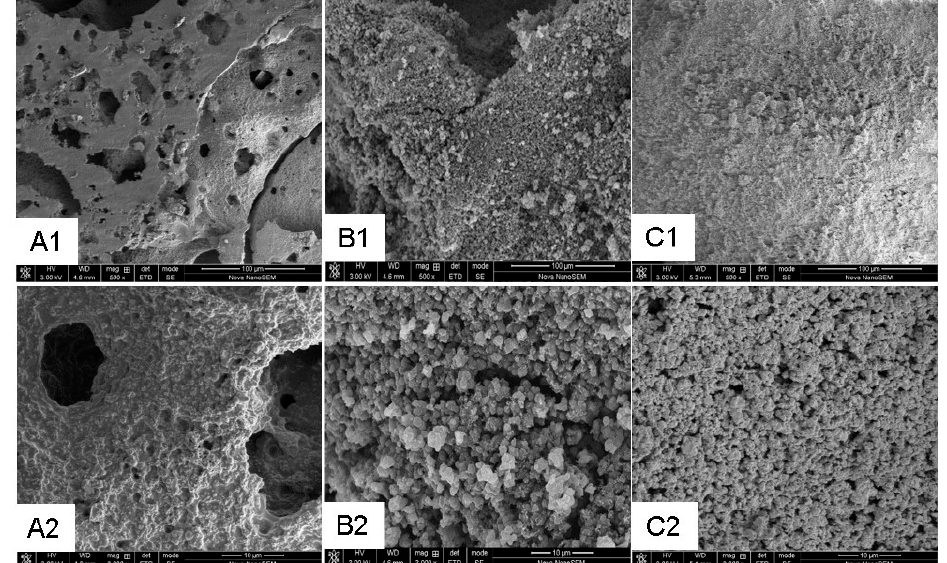
Figure 9. SEM images of the char residues of PLA and its flame retardant composites. 500 × , 3000 × ( A1 , A2 ) of the residues for PLA; 500 × , 3000 × ( B1 , B2 ) of the residues for PSQ-PLA; 500 × , 3000 × ( C1 , C2 ) of the residues for P 5 PSQ-PLA.